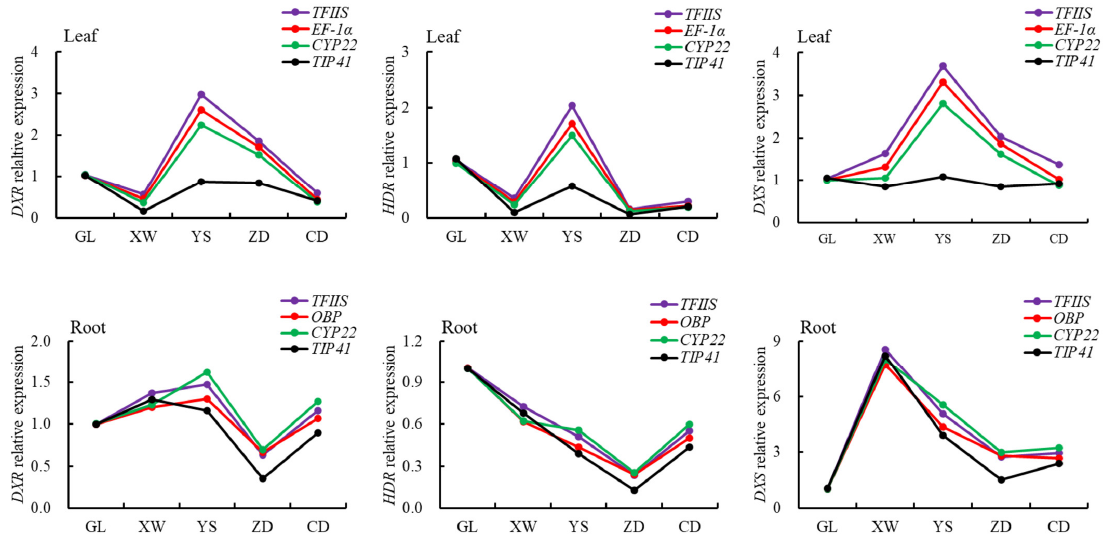
Figure 8. The relative expression of DXR , HDR , and DXS of L. rotata roots and leaves in different regions. TFIIS, EF-1 ɑ , CYP22, OBP, and TIP41 all were reference genes. DXR, HDR , and DXR all were target genes related to the biosynthetic pathway of iridoid compounds in L. rotata . The purple curve was based on the TFIIS reference gene , the red curve was based on the EF-1 ɑ reference gene in leaves or OBP reference gene in roots , the green curve was based on the CYP22 reference gene, and the black curve was based on the TIP41 reference gene.